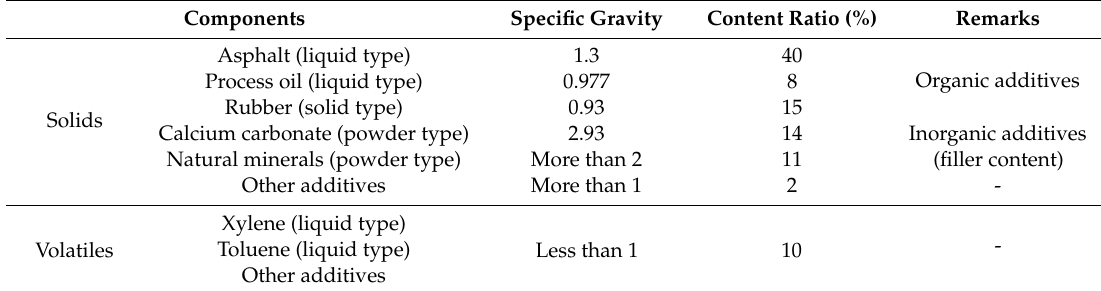
Table 1. General components of emulsion-based non-curable synthetic polymer rubberized gel (ENC-SPRG) (for example).